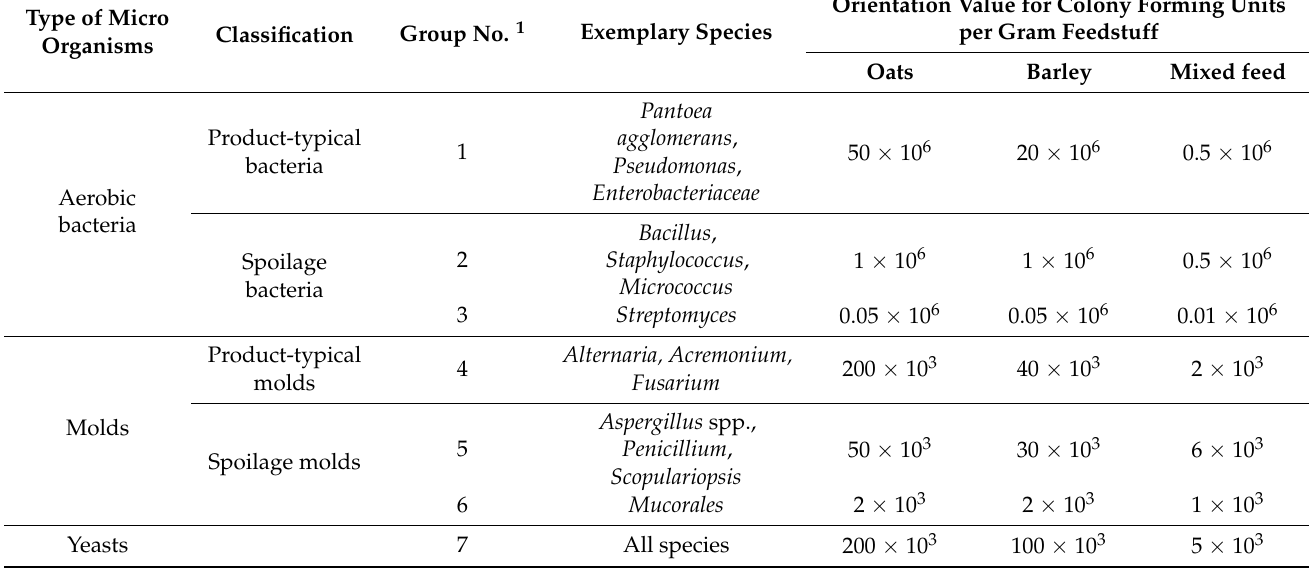
Table 2. Orientation values for microbial counts of different concentrates in accordance with VDLUFA